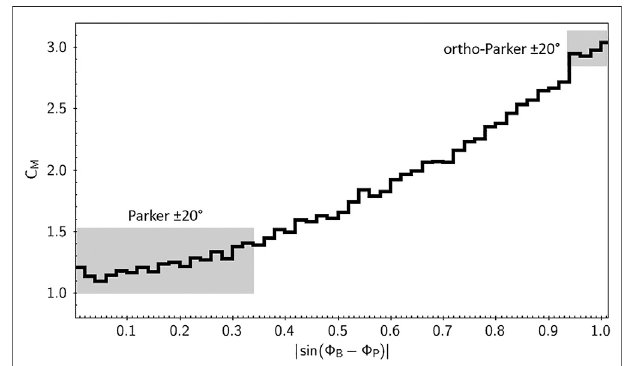
FIGURE 5 | Median of the threshold C M per bin of |sin( Φ B − Φ P )| (for a perpendicular shock with r s (cid:1) B 2 / B 1 (cid:1) 3.5). Parker orientations ± 20 ° are shown in the grey box on the left and the ortho-Parker orientations ± 20 ° are shown in the upper right grey